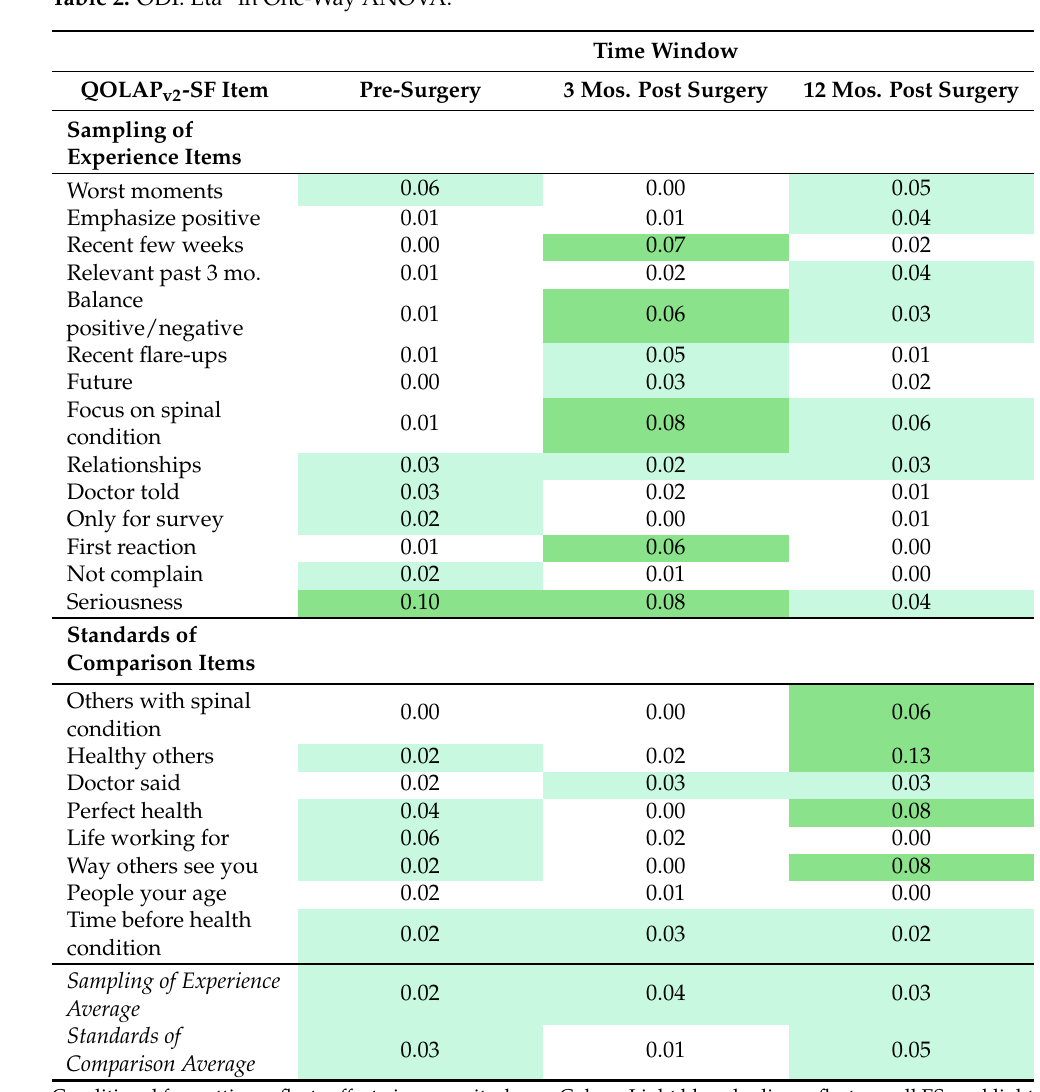
Table 2. ODI: Eta 2 in One-Way